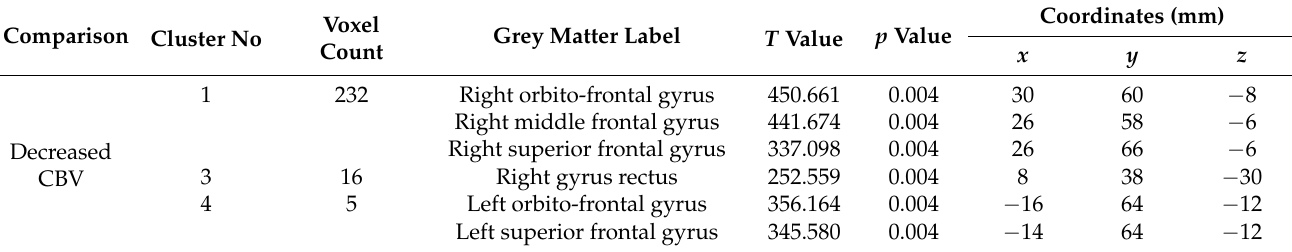
Figure 2. Mapping of CBV status after ST versus CBV status before ST as adjusted for sex and age. The brain regions marked in blue are regions with decreased activation after ST treatment in the ST group. A, anterior; P, posterior; L, left; R, right; I, Inferior; S, Superior. Table 3. Clusters of decreased CBV after scrambler therapy relative to CBV before scrambler therapy.